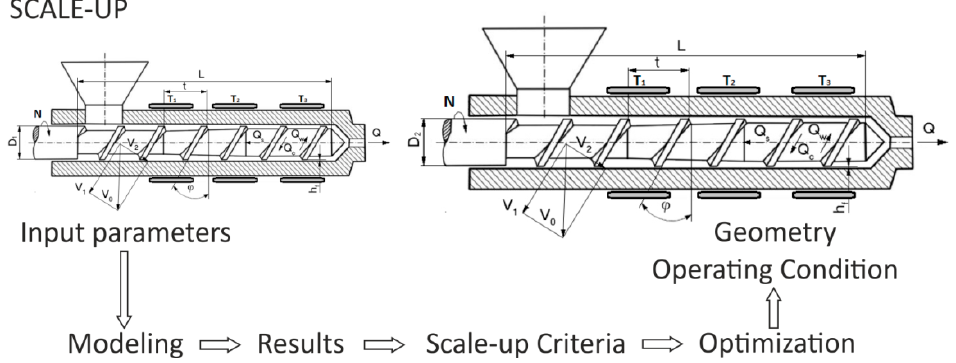
Figure 9. The modeling/optimization concept of scaling-up for polymer extrusion: D 1 —reference screw diameter, D 2 —target screw diameter.